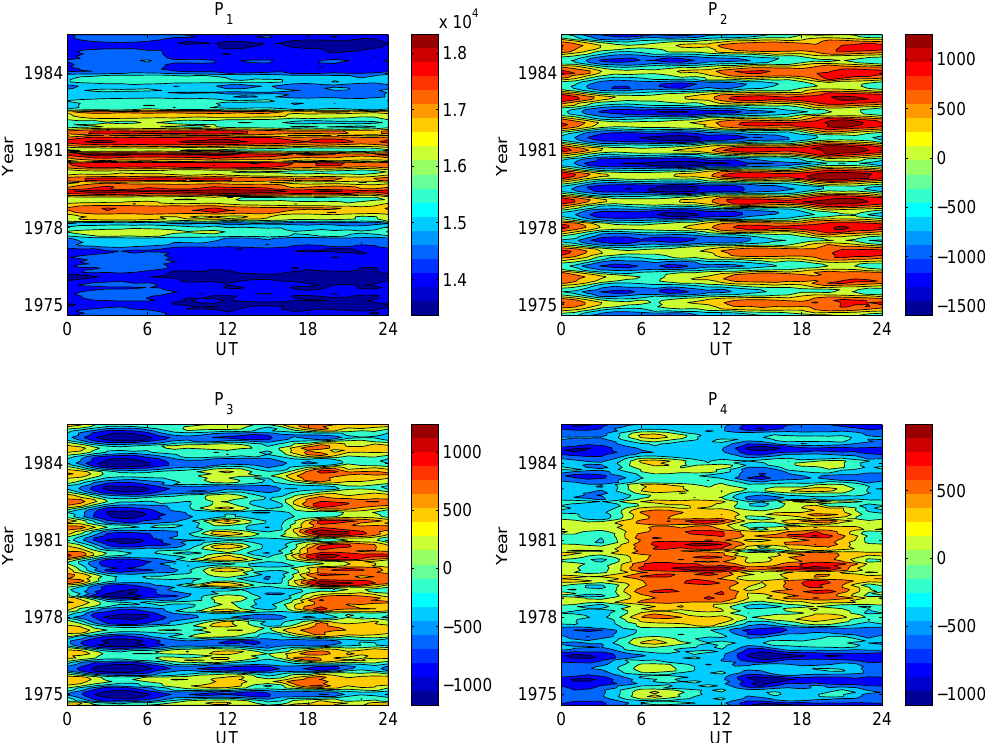
Fig. 4. Distribution of the coefficients ( P 1 – P 4 ) corresponding to the first four orders of base functions ( E 1 – E 4 ) shown in Fig. 3 obtained with the first layer EOF decomposition of hm